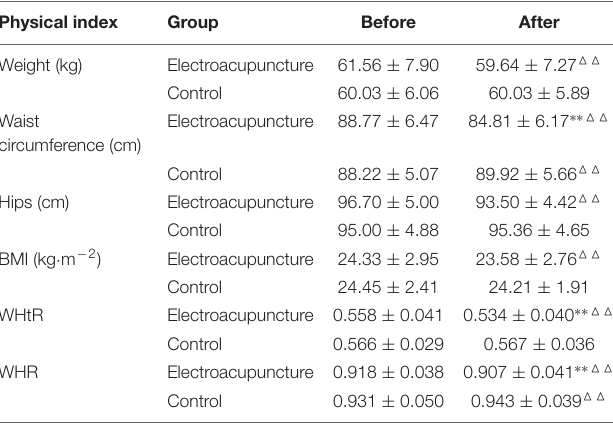
TABLE 2 | Comparison of physical indexes between two groups of patients before and after the